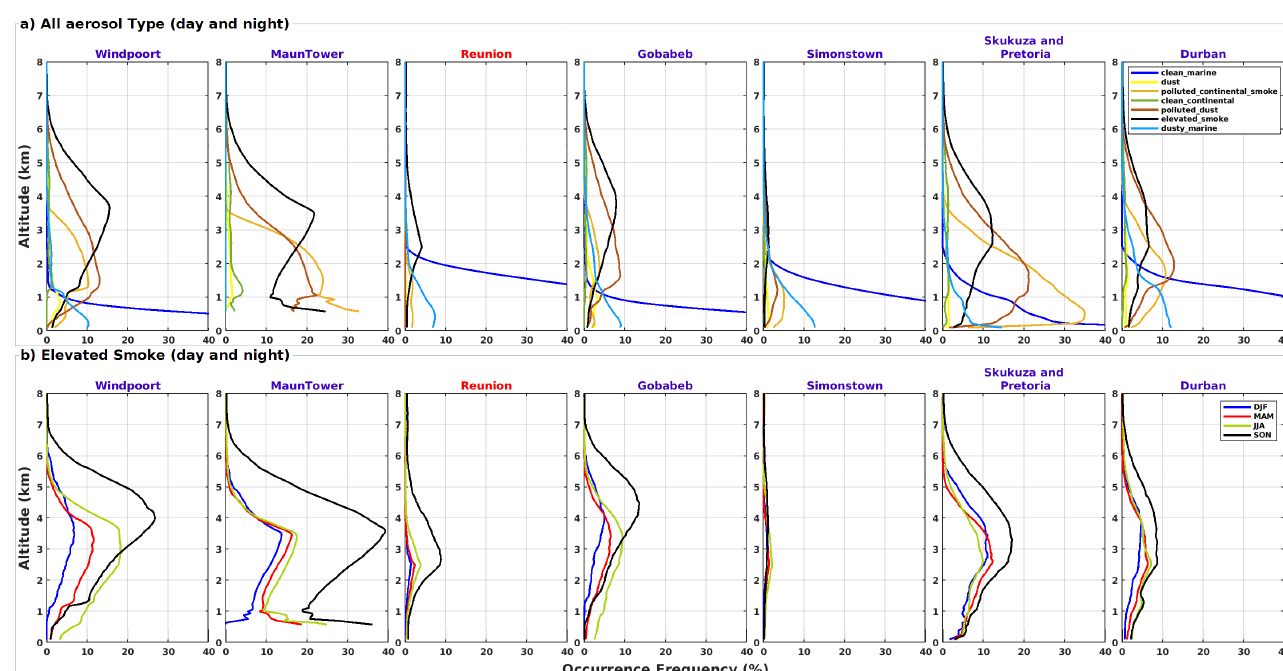
Figure 8. Vertical distribution of occurrence frequencies of aerosol types from CALIOP over the eight sun photometer sites. ( a ) Multiyear average annual values of all aerosol types: clean marine (dark-blue line); dust (yellow line); polluted continental/smoke (orange line); clean continental (green line); polluted dust (brown line); elevated smoke (black line); and dusty marine (sky-blue line). ( b ) Multiyear seasonal average values of elevated smoke: summer (DJF, dark-blue line), autumn (MAM, red line), winter (JJA, light-green line), and spring (SON, black